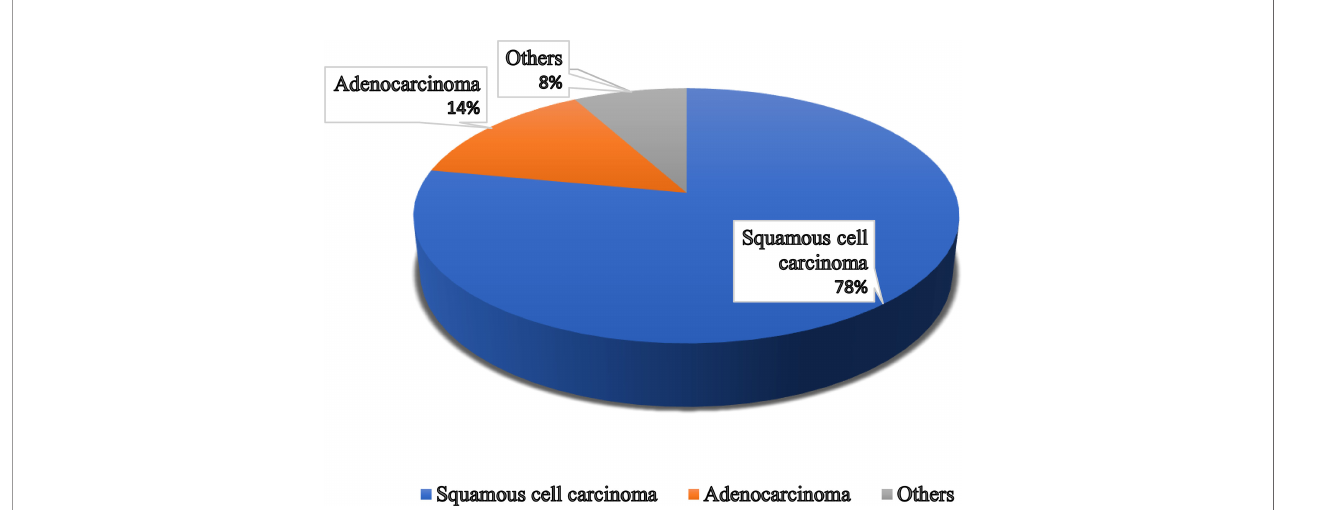
FIGURE 1 | Different types of vaginal cancer and their infection rate. Various types of vaginal cancer are found in different parts of the vagina. Among them, squamous cell carcinoma, which is linked to the vaginal surface area and arises from epithelial cells, is the most prominent type of vaginal cancer. Adenocarcinoma is also found as a common type of vaginal cancer, which is responsible for 15% of all vaginal cancers. Besides, endrometriosis, testicular and some other types of cancer are noticed in the vaginal